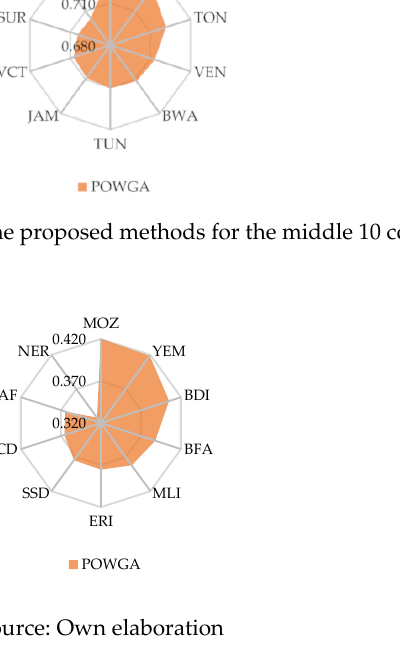
Figure 4. Comparison of the proposed methods for Worst 10 countries.